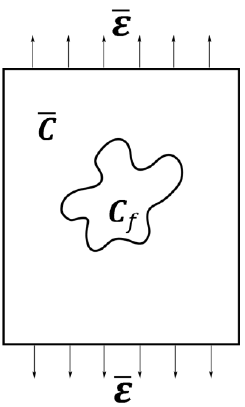
Figure 1. The single-filler transition of self-consistent approach in the RVE.